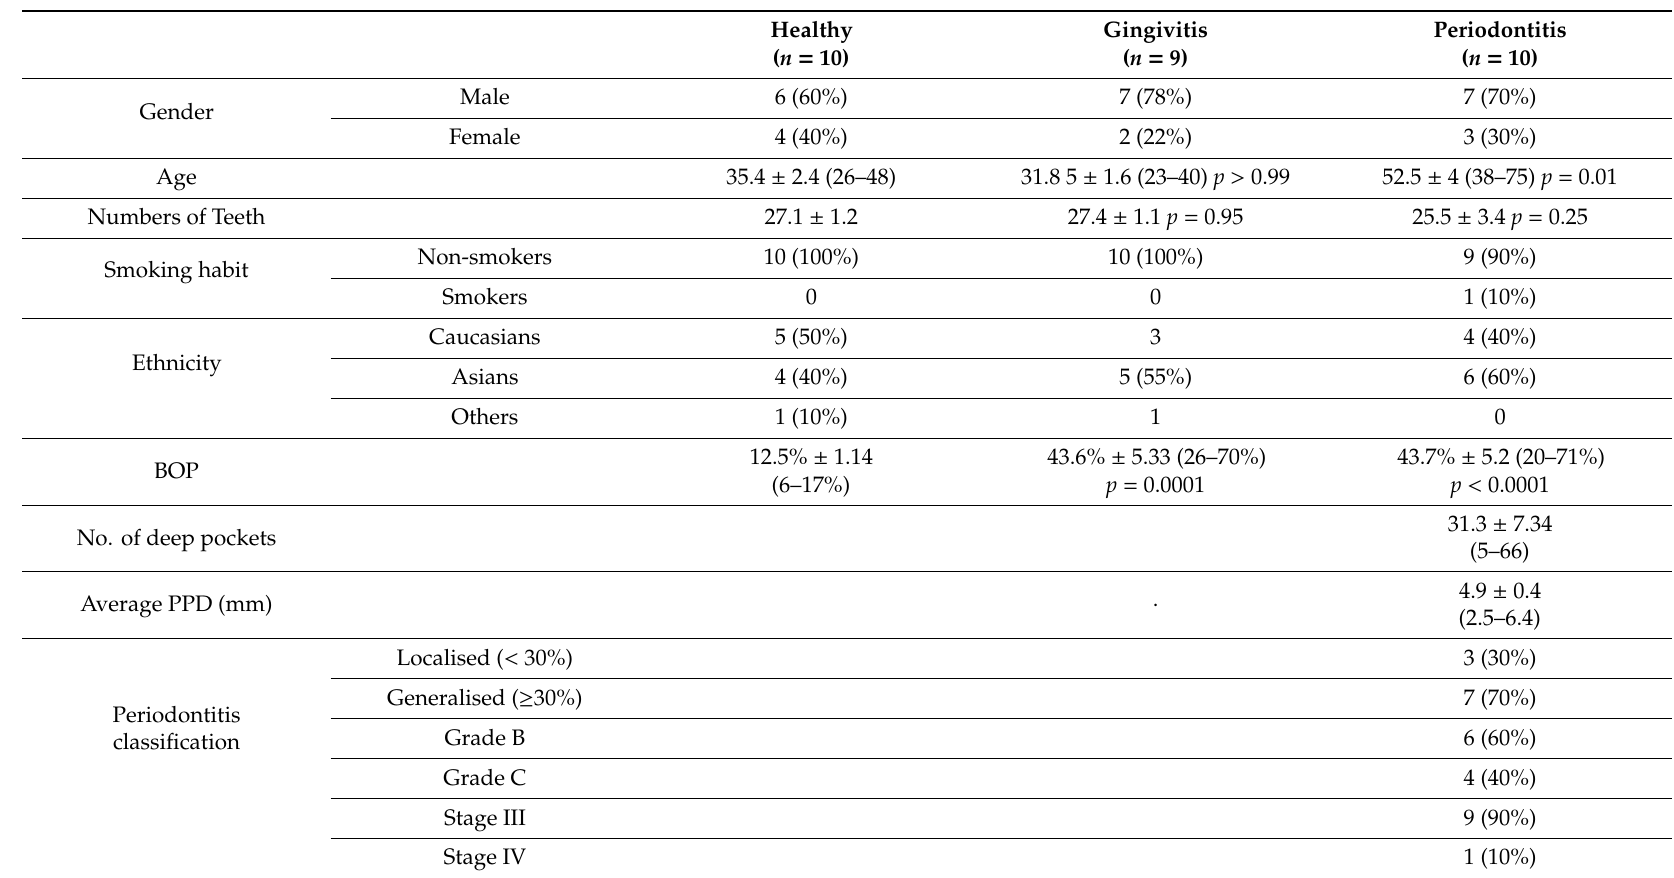
Table 1. Demographic and clinical characteristics of the study